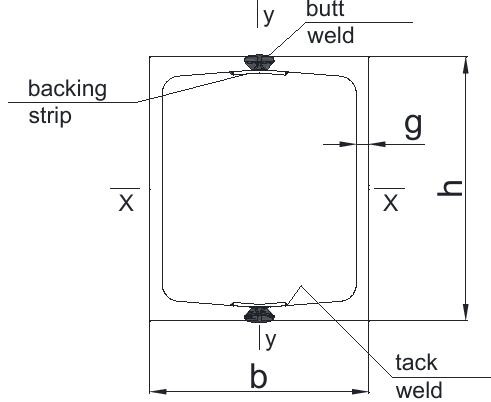
Fig. 2. Cross-section of a steel guide made of channel sections [9] 